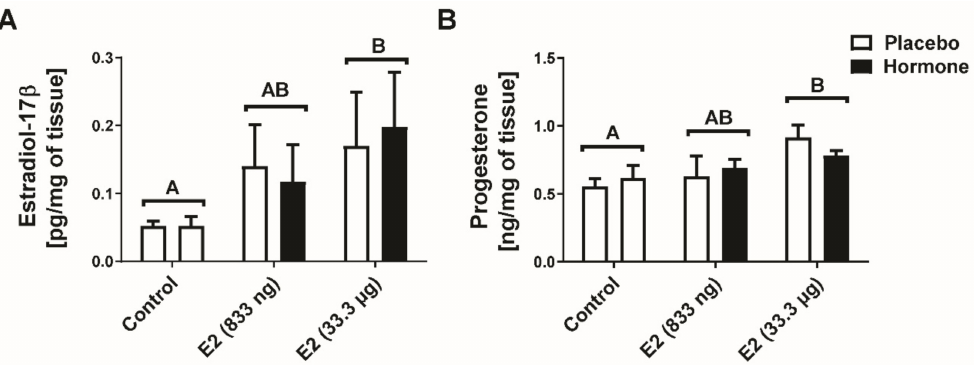
Figure 1. The concentration of estradiol-17 β (E2) ( A ) and progesterone ( B ) in corpora lutea adjacent to placebo- and hormone-treated horns. Control—gilts receiving placebo infusions into both uterine horns. E2—gilts receiving infusions of either placebo into one randomly selected horn or E2 (833 ng or 33.3 µ g/infusion) into contralateral horn. Data are expressed as the mean ± SEM. Main effect of treatment was detected on luteal concentration of E2 and progesterone (E2-treated groups vs. the control group; p < 0.05). There was no significant main effect of the site of hormone administration (i.e., the placebo-treated uterine horn vs. the hormone-treated uterine horn within the same animal) on luteal concentration of E2 and progesterone. Therefore, the different letters (above two bars for each group) indicate statistically significant differences between the control gilts and high-dose of E2-treated gilts ( p <